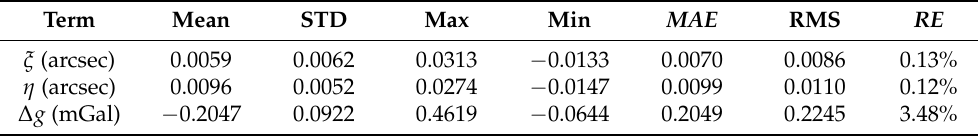
Table 1. Statistics on the accuracy of the recovered DV and